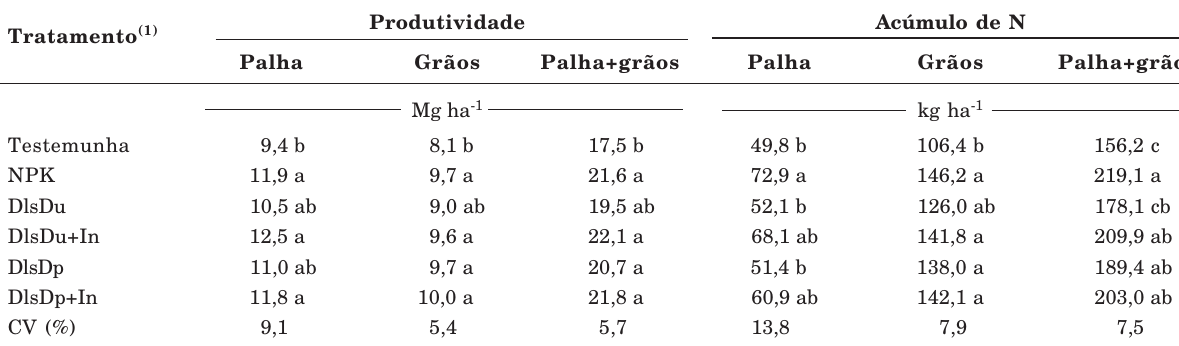
(1) Dls: Dejetos líquidos de suínos; In: Inibidor de nitrificação; Du: Dose única; e Dp: Dose parcelada. Médias de tratamentos seguidas pela mesma letra na coluna não diferem entre si pelo teste de Tukey a 5